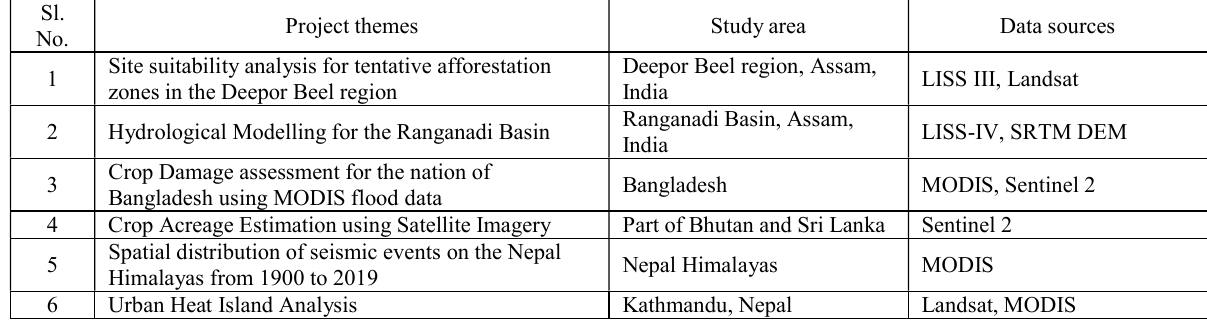
Table 2. List of mini projects with study area and sources of data